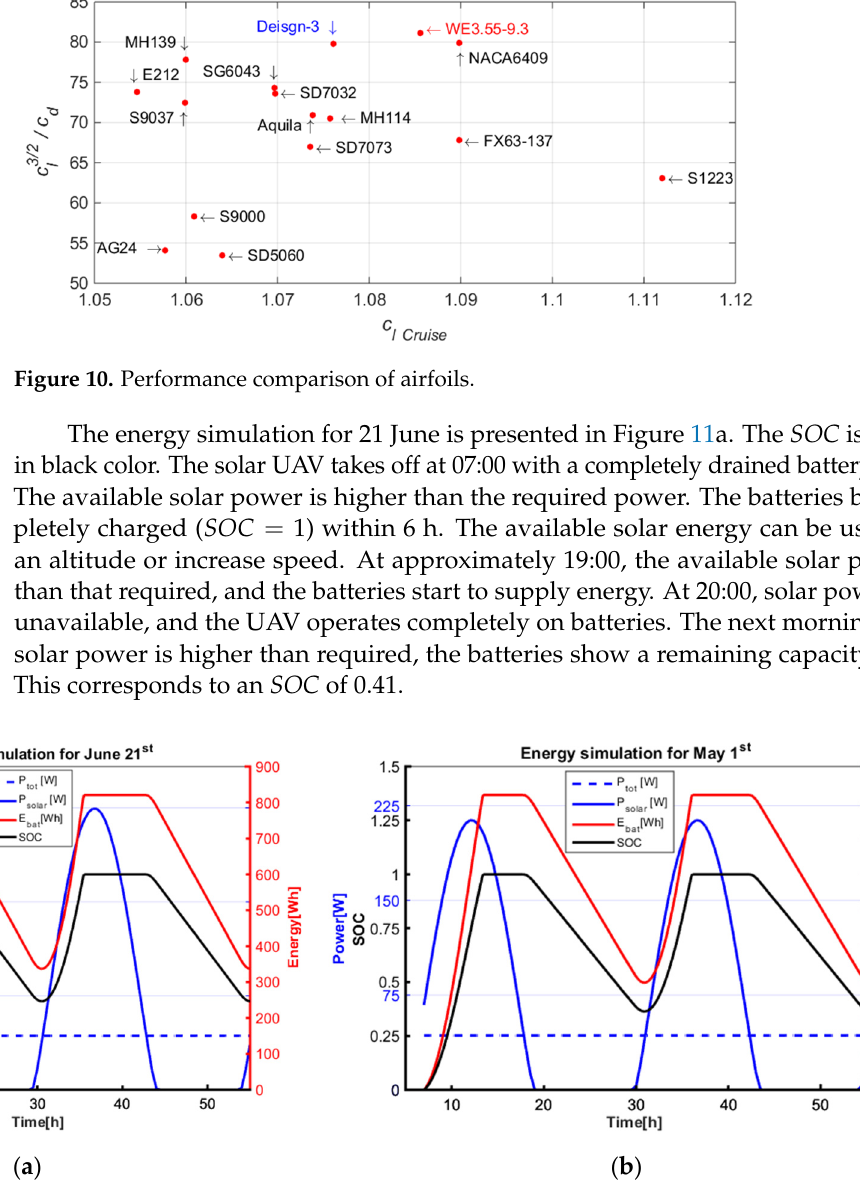
Figure 11. Design-3, energy simulation: ( a ) 21 June and ( b ) 1 May.